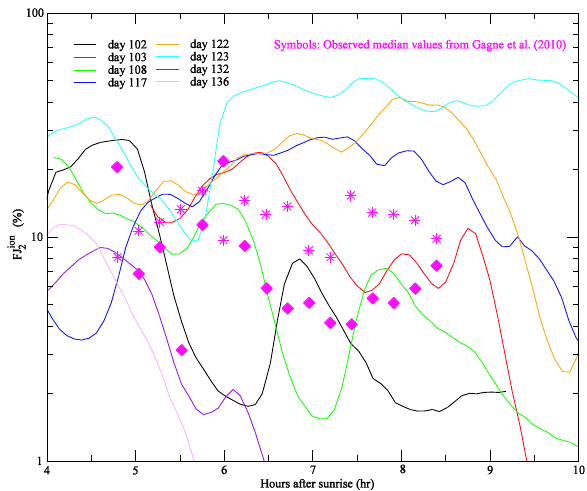
Fig. 5. The apparent fraction of 2-nm particles formed on ions ) as a function of hours after sunrise for all 8 case study days ( FJ ion 2 described in Yu and Turco (2008). Symbols represent the observed median values of FJ ion obtained by Gagn´e et al. (2010) (stars: over- 2 charged days; diamonds: undercharged